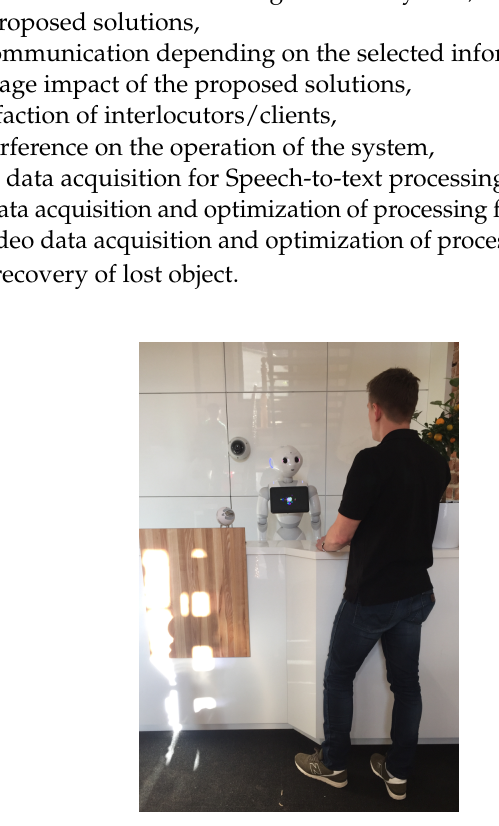
Figure 6. Real-world implementation of the proposed concept. Prototype system with humanoid